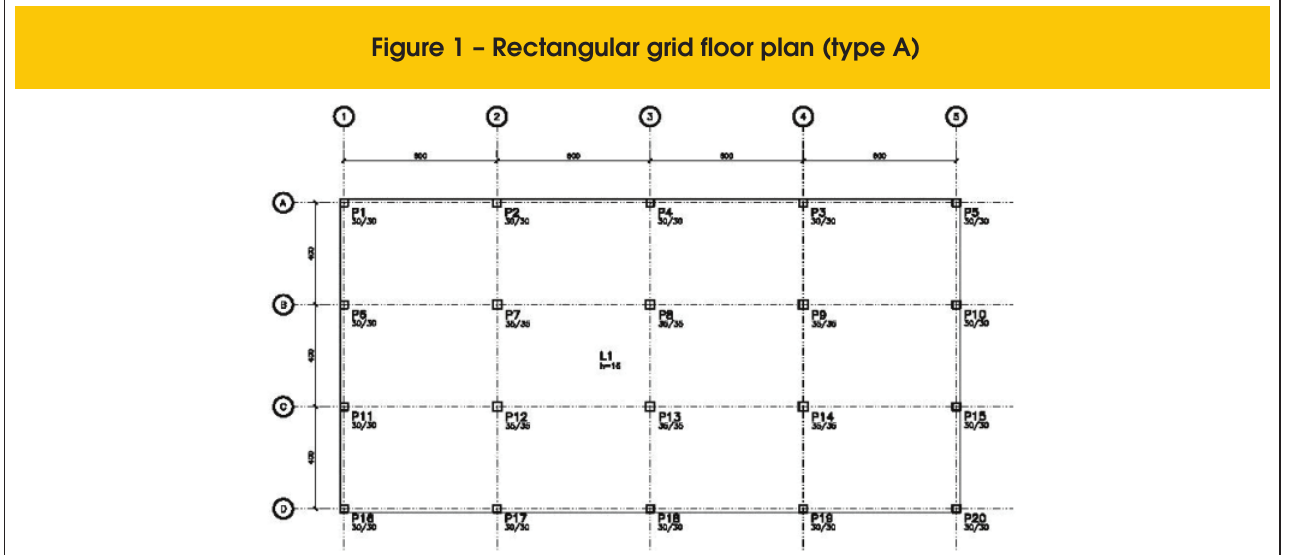
Figure 1 – Rectangular grid floor plan (type